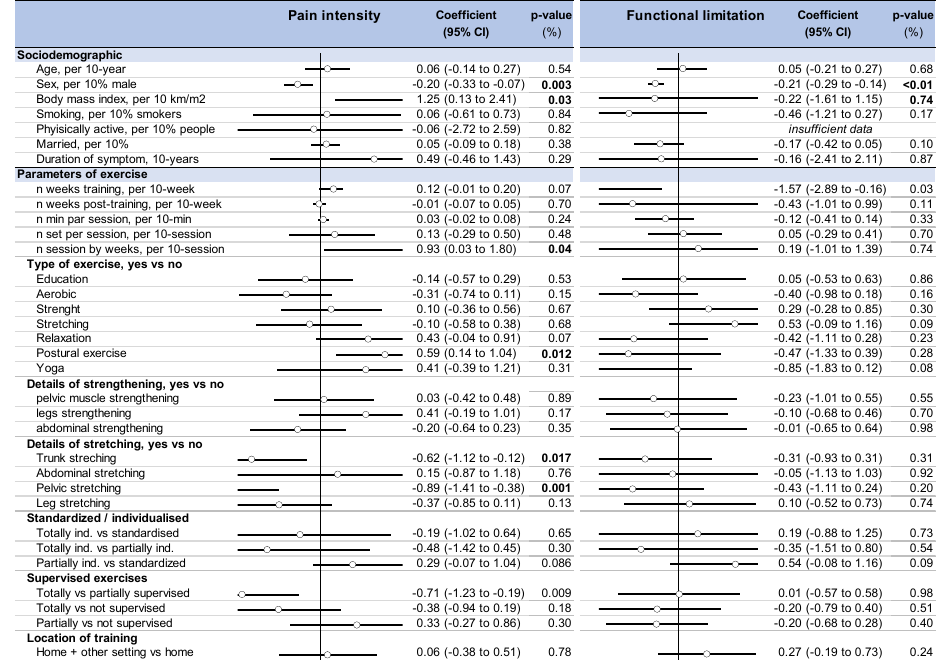
Figure A3. Metaregressions (i.e., putative influencing variables on pain intensity and functional limitation following home-based exercise in LBP), using only the median time of follow-up.